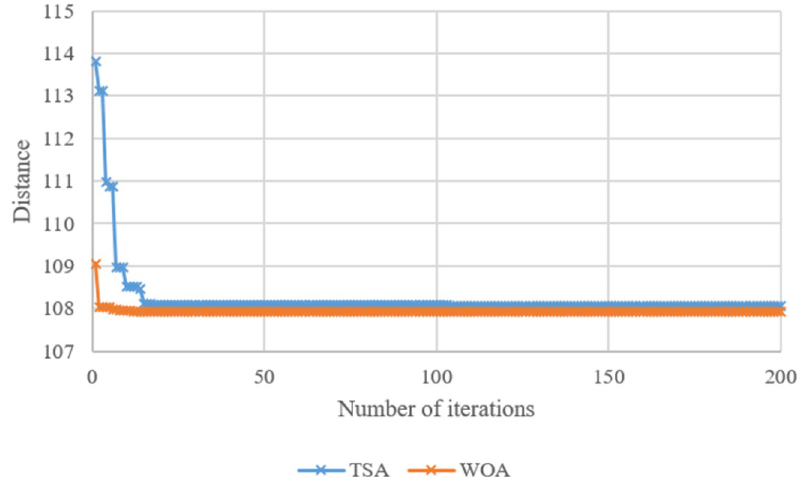
Fig 10. Search history of TSA and WOA for Case- 30